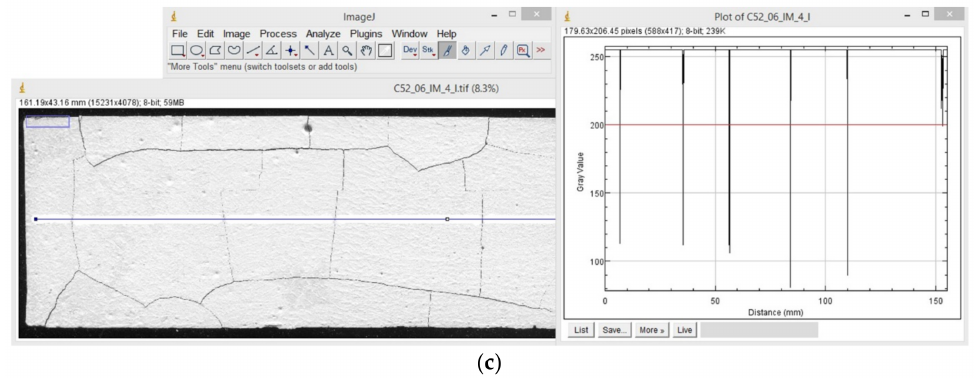
Figure 2. Scanned surface of the cement paste: ( a ) the primary image; ( b ) the image after processing and the A and L measurements; ( c ) the image after processing and the I measurements; 1—the clusters; 2—cracks forming the separation surface between clusters; 3—the cluster perimeter; 4—the cluster